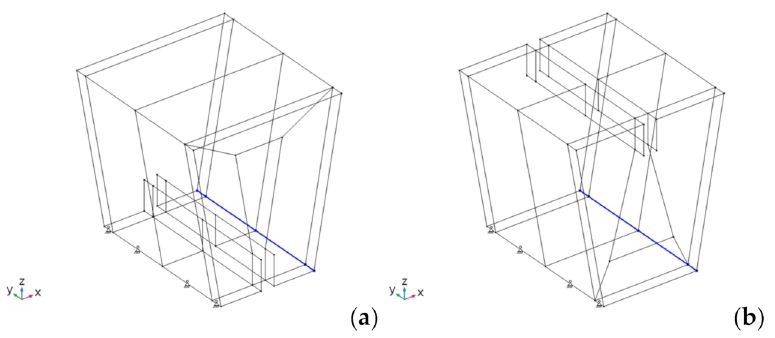
Figure 13. Boundary conditions applied to the 1st design with bottom ( a ) and top ( b ) discontinuity.